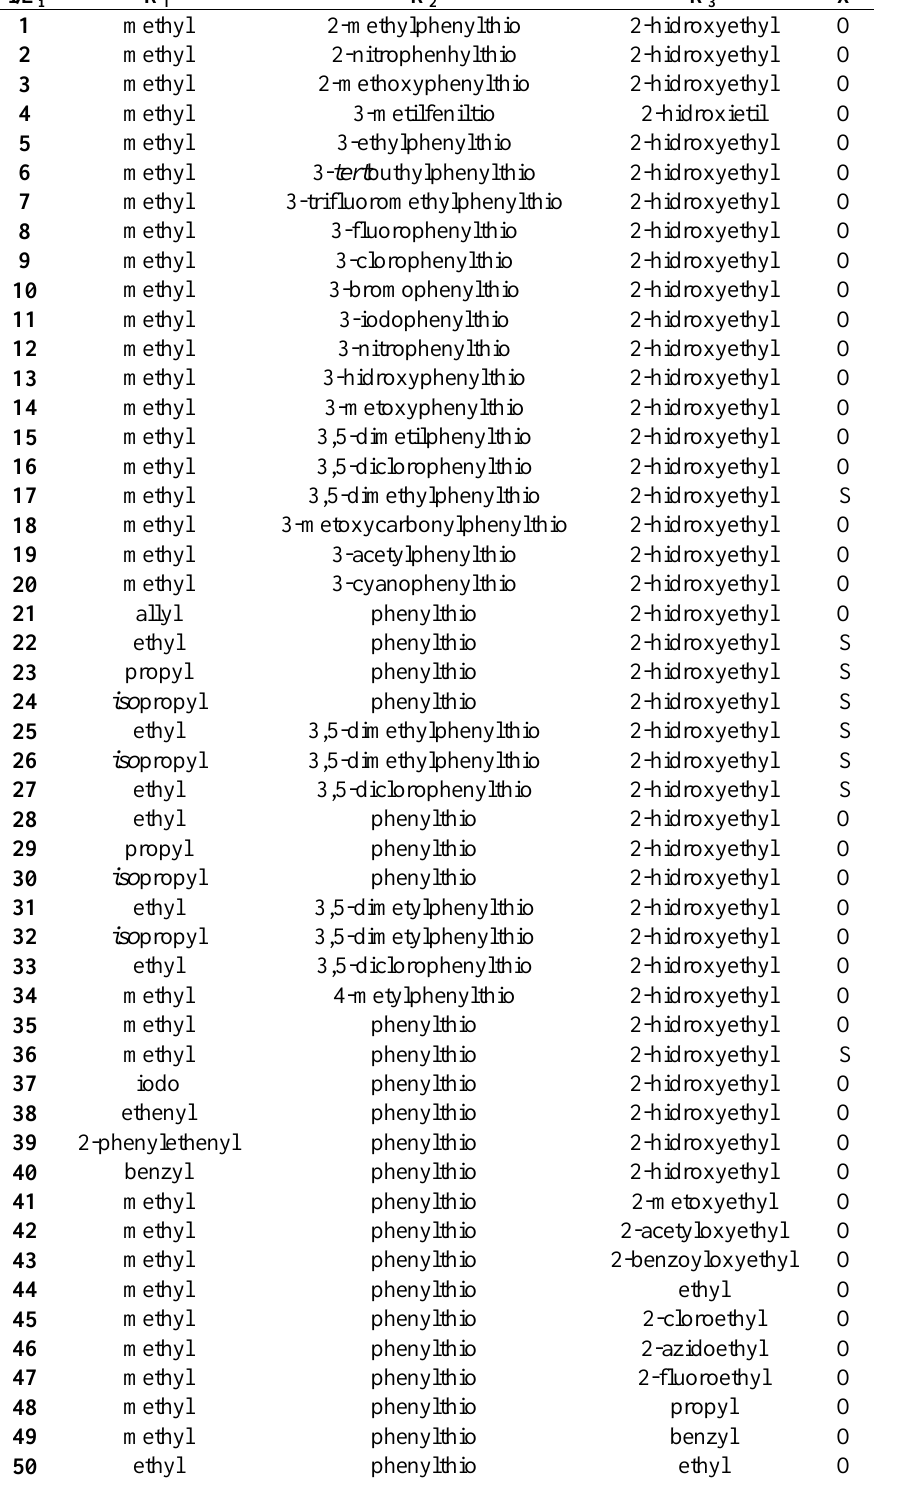
Table I. The series of structures of the studied HEPT ligand molecules of types of Figure 3. i/L